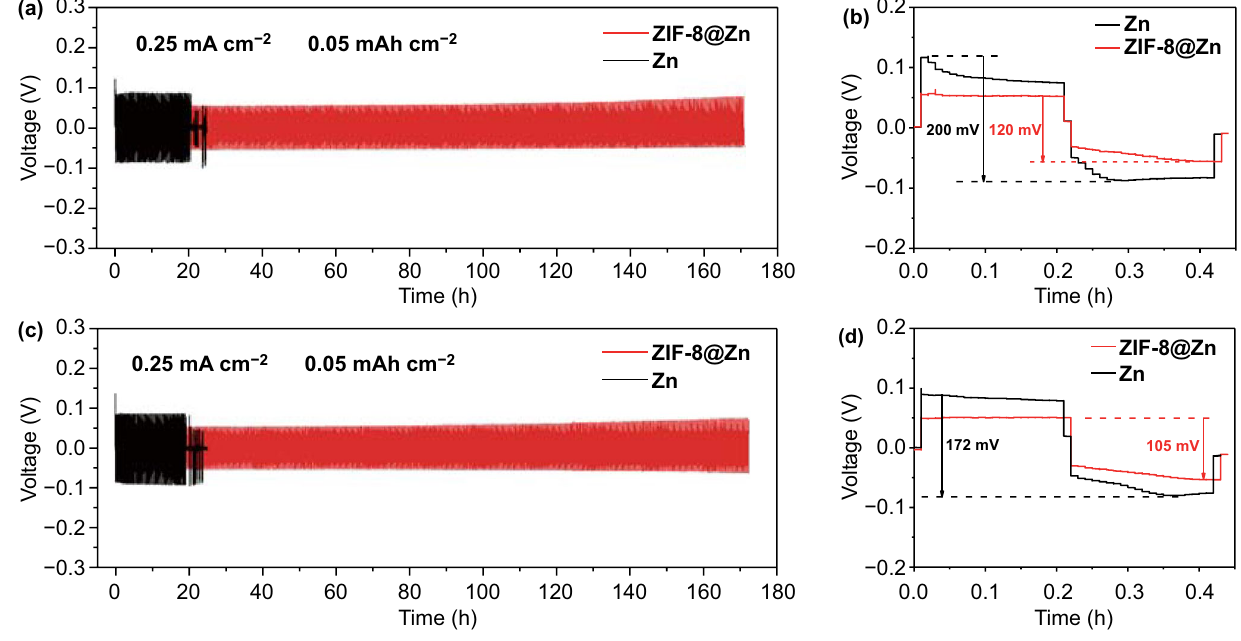
Fig. 5 Cycling performance of symmetrical cells with bare Zn foil and ZIF‑8@Zn electrodes in a and b 2 M ZnSO 4 and c and d 2 M ZnSO 4 + 0.1 M MnSO 4 electrolytes. Applied current density is 0.25 mA cm −2 with Zn deposition/dissolution capacity of 0.05 mAh cm −2 . b , d The first‑cycle voltage profiles of symmetrical cells with bare Zn foil and ZIF‑8@Zn